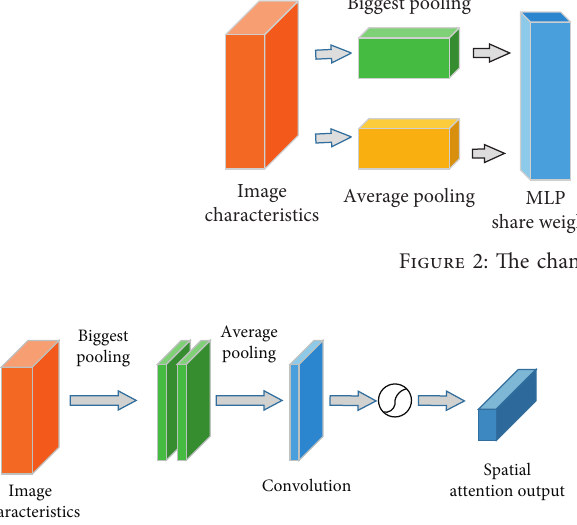
Figure 3: The spatial attention structure.